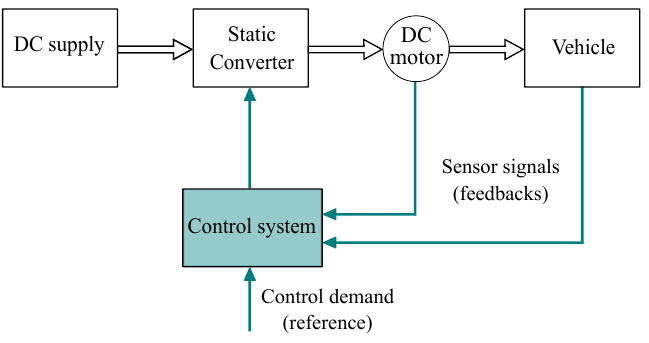
Figure 14. BLDC motor scheme.